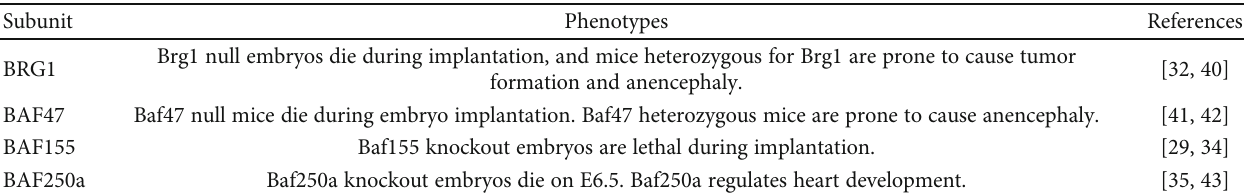
Table 2: The role of BAF subunits in early mouse embryonic